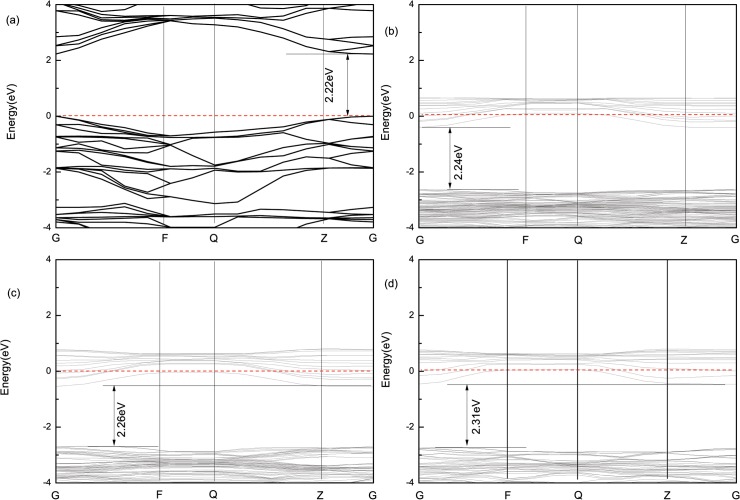
Band structure for pure and W-doped anatase TiO2.(A) pure anatase TiO2 unit cell, (B) Ti0.97917W0.02083O2 supercell, (C) Ti0.96875W0.03125O2 supercell, (D) Ti0.95833W0.04167O2 supercell.